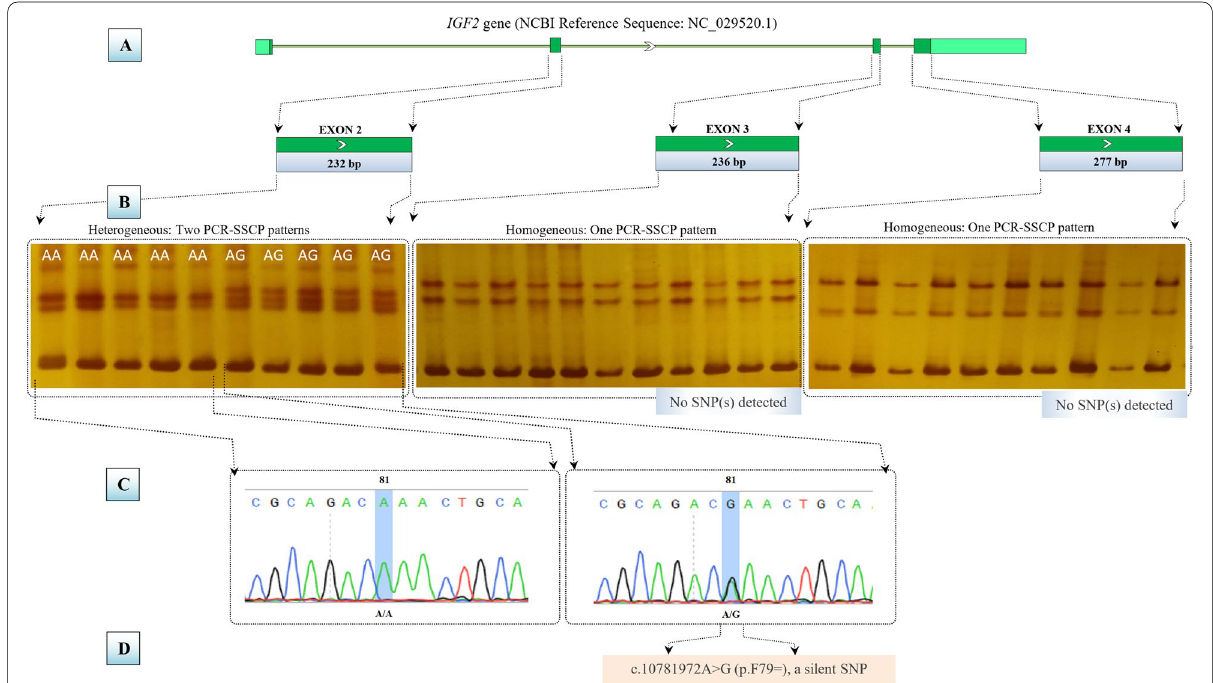
Fig. 1 A schematic diagram for the IGF2 gene‑based PCR‑SSCP‑sequencing strategy in three lines of Japanese quails. A PCR design of three PCR‑specific primers pairs for the amplification of 232 bp, 236 bp, and 277 bp in exon 2, exon 3, and exon 3, respectively. B Post‑PCR genotyping using SSCP technique, in which only exon 2 showed two different genotypes. C Sequencing reactions interpretation of the detected genotypes, in which only one SNP was detected in the exon 2. D Characterization of the observed SNP, in which a silent effect p.F79 detected SNP. The positions of primers and the nomenclature of the observed SNPs are listed according to NCBI Reference Sequence: NC_029520.1 following the nomenclature described in varno men. hgvs.